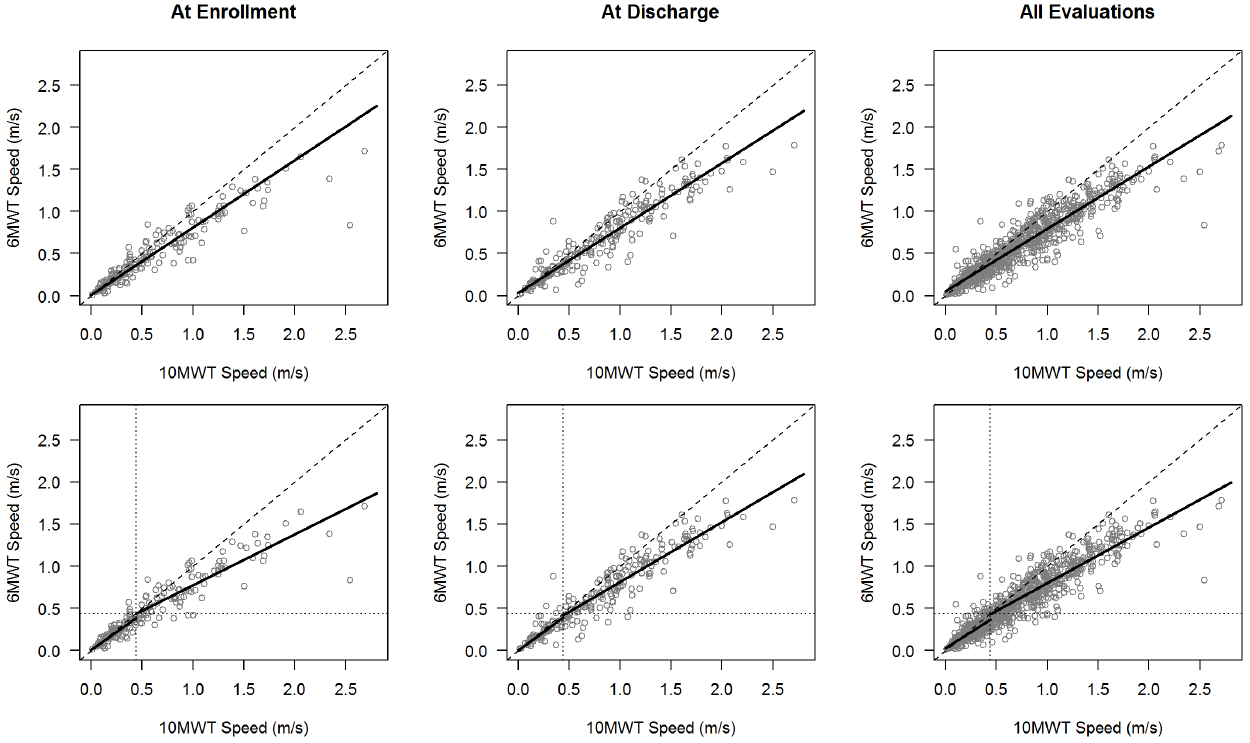
Figure 1. Lines of best fit from linear models predicting 6MWT speeds with 10MWT speeds at enrollment, discharge, and all evaluations. Top row: linear models fit to all observations. Bottom row: linear models fit to slow and fast walkers (separated by dotted line). Dashed line is 45-degree line of agreement. doi:10.1371/journal.pone.0094108.g001 PLOS ONE |